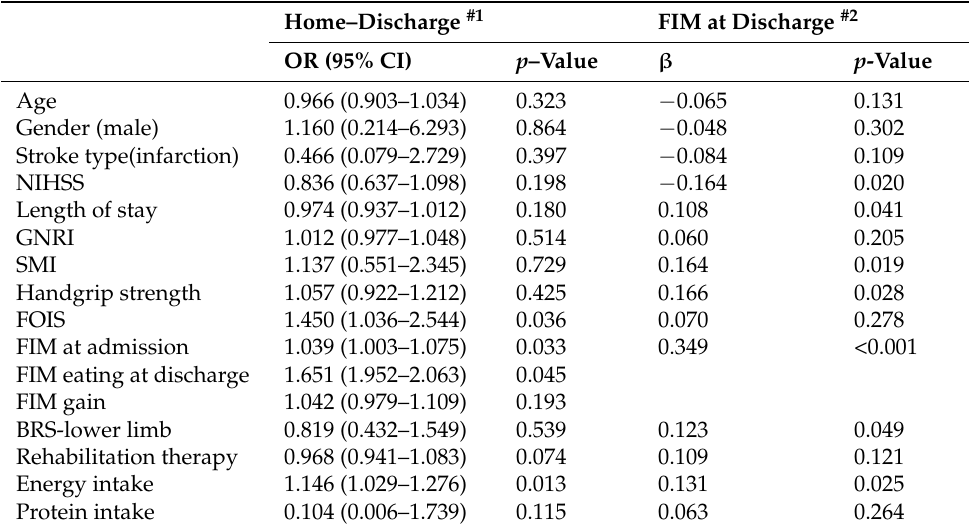
Table 2. Multivariate analysis for home discharge and FIM at discharge.